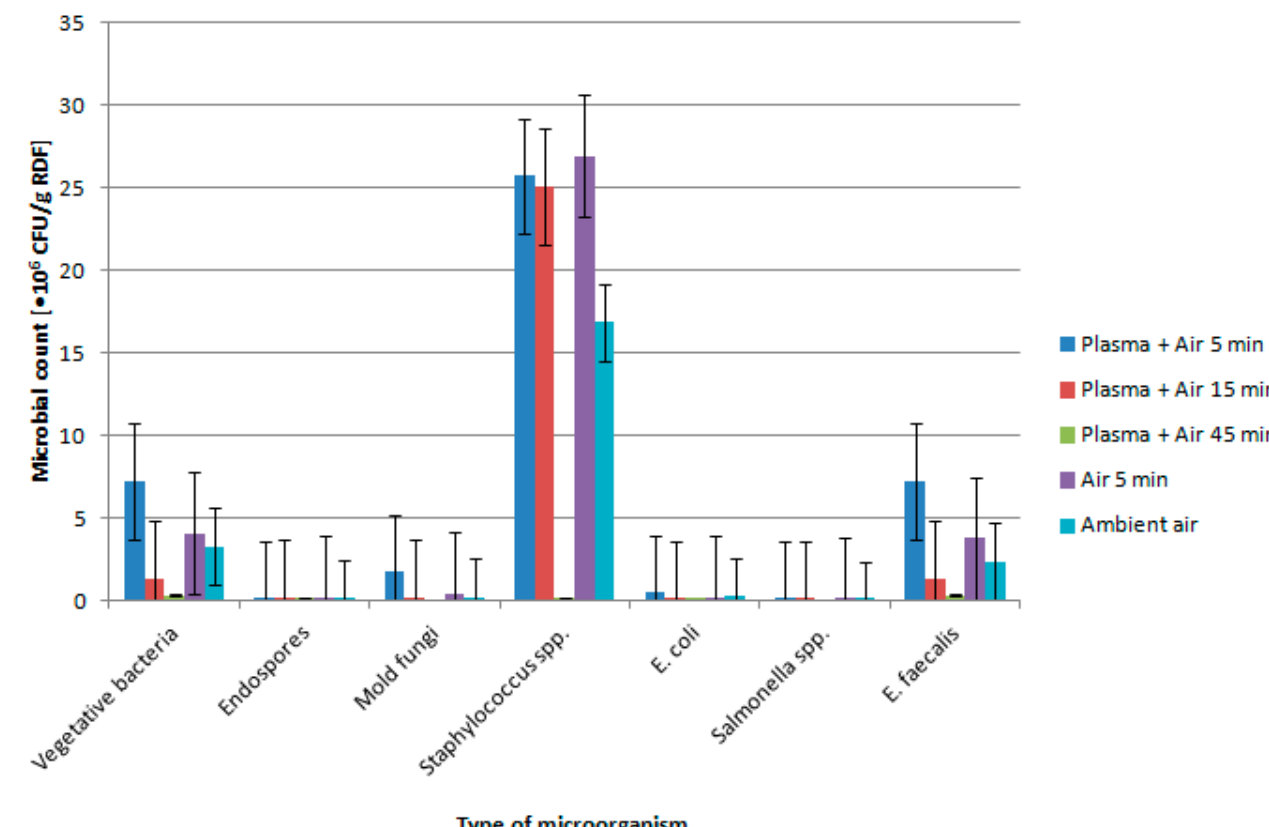
Figure 3. Averaged microbial count for batches 1–3, 4–6, 7–9 with control batches 10–12 and 13–15.